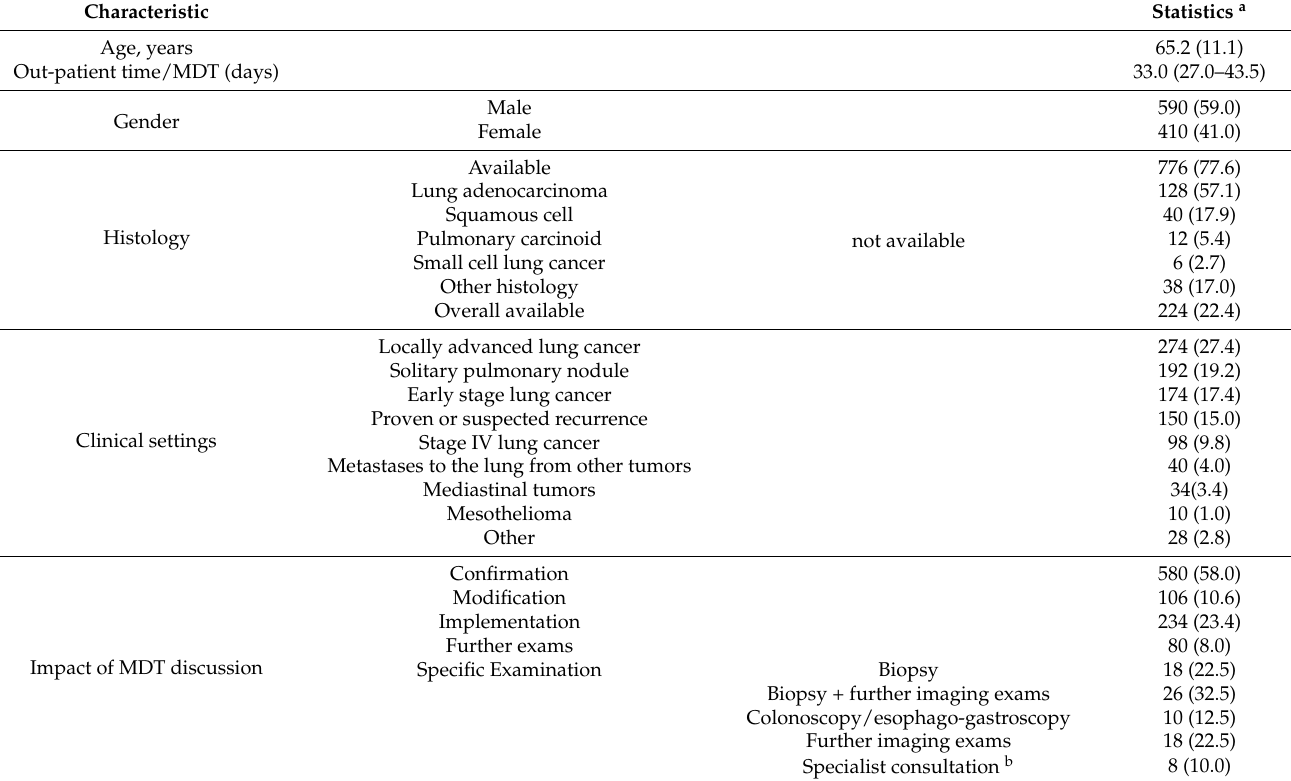
Table 1. Patients’ demography, clinical setting and MDT impact summary statistics, N =